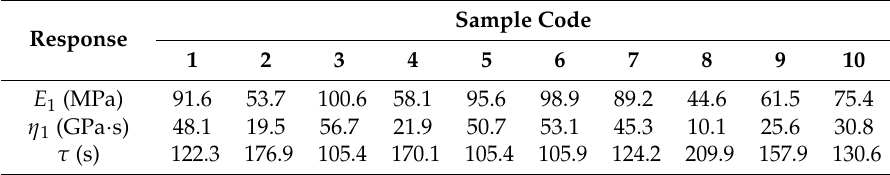
Table 5. Viscoelastic responses of SLD for asphalt mortars (F1~F10).